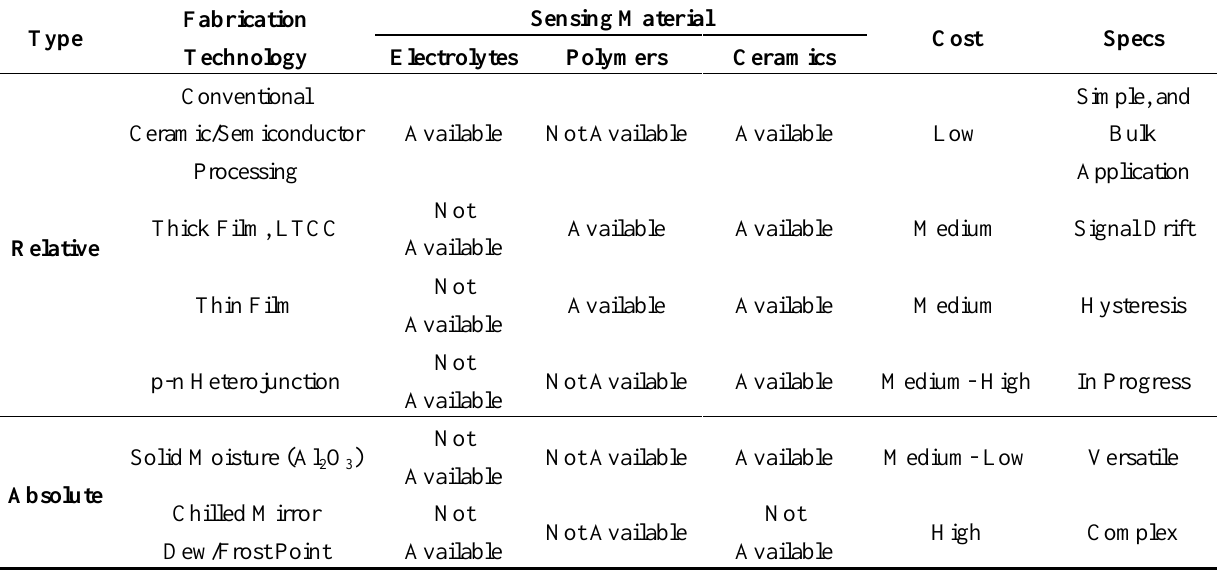
Table 1. The state-of-the-art of humidity sensors based on fabrication technologies and sensing